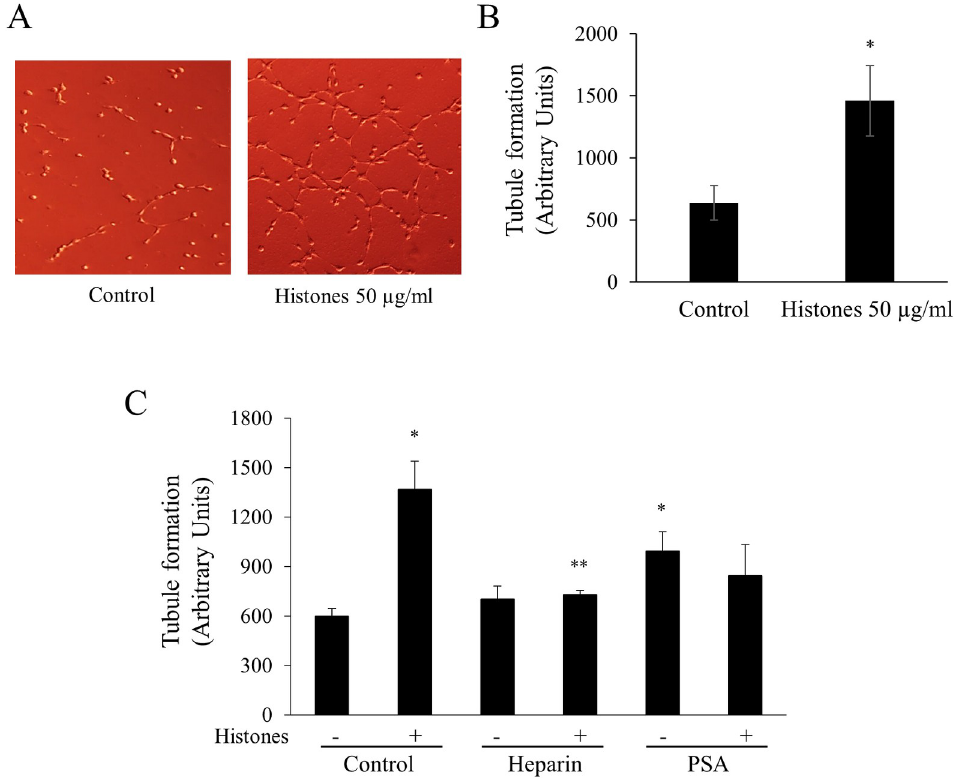
Fig 5. NETs promote endothelial cell angiogenesis. (A) Endothelial cells EA.hy926 were incubated with or without histones (50 μ g/mL) for 4 h in a Matrigel–coated well and tubule images were taken under an optical microscope ( × 100). (B) EA.hy926 (5 × 10 4 cells/well) were incubated with various concentrations of histones (none, 10, 20, 50, 100 μ g/mL) for 4 h in Matrigel-coated wells. The tubule formation length was calculated by Image J software in four randomly selected fields. (C) As inhibitors of tubule formation, heparin (100 IU/mL) and PSA (62.5 μ g/mL) were pre- incubated with or without histones for 1 h. EA.hy926 cells were then added for 4 h. � P < 0.05 versus control; �� P < 0.05 versus